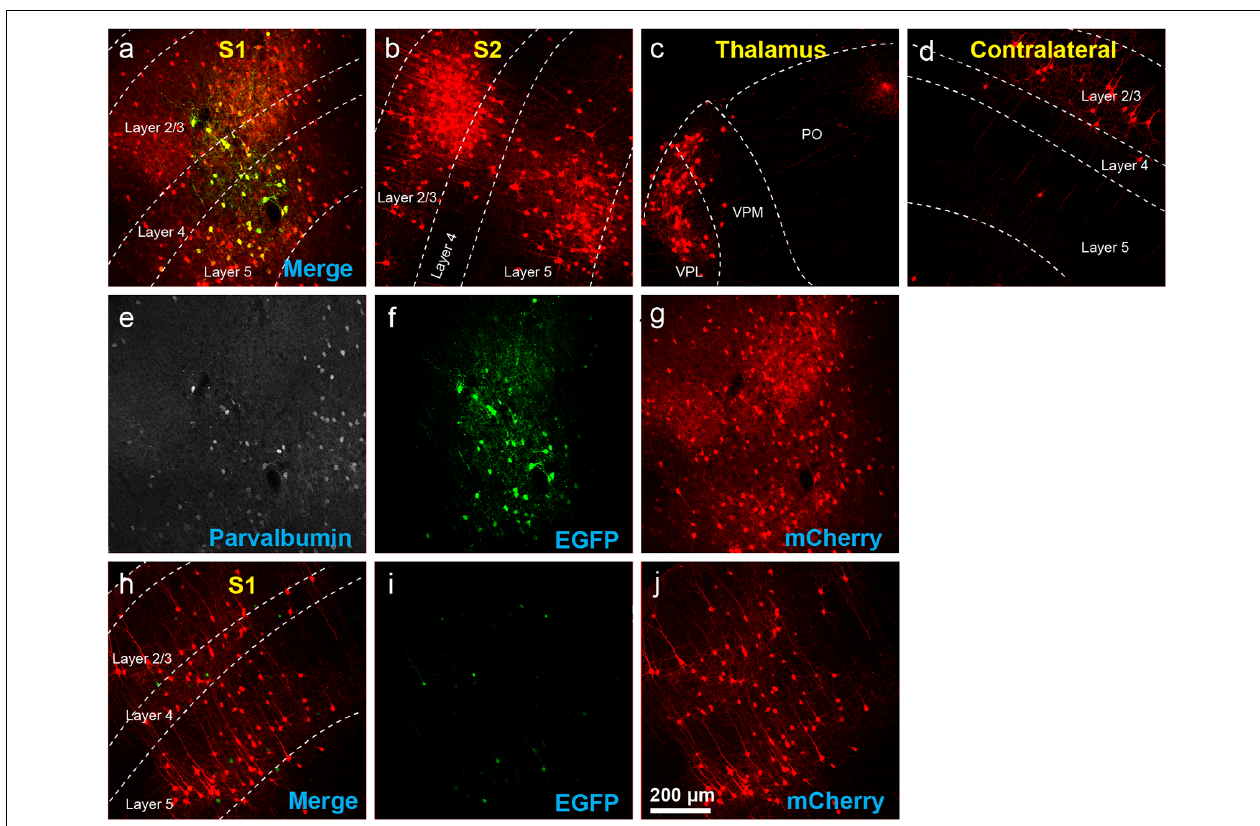
FIGURE 7 | Results using recommended dilutions of the single tricistronic helper. (A–G) Use of the single tricistronic helper AAV at 1:10 dilution (see main text) also labeled many presynaptic neurons (but see Figure 7 ). (A) Injection site in S1; individual channels from this field are shown in panels (E–G) . (B) Labeled neurons in ipsilateral S2. (C) Labeled neurons in ipsilateral thalamus (VPL, VPM, and Po). (D) Labeled neurons in contralateral S1. (E) Anti-parvalbumin staining (not shown in panel A ). (F) Anti-EGFP staining, indicating expression from the first, Cre-dependent AAV. (G) mCherry, indicating the presence of the ∆ G RV. (H–J) Injection